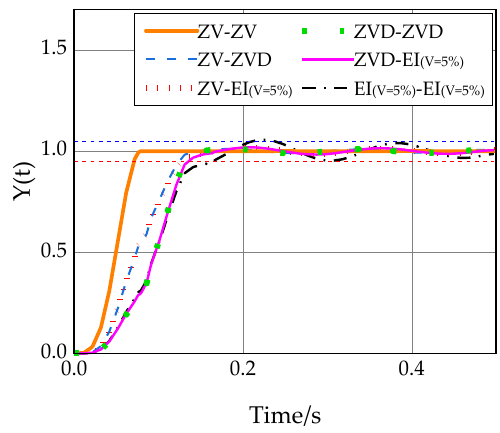
Figure 14. Unit step response of each dual-mode input